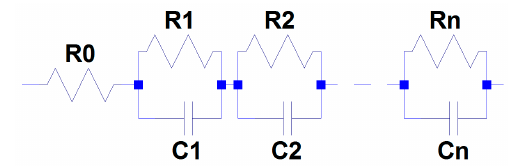
Figure 2. Equivalent circuit implementing (9).